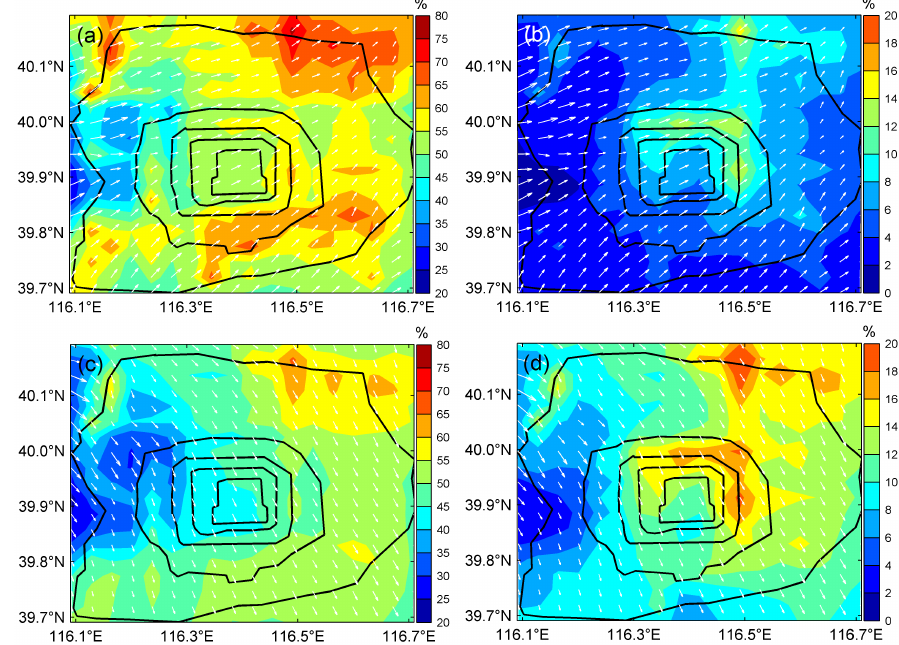
Figure 9. The spatial distribution of mean contribution rate of vehicle emission on NO 2 and PM 2 . 5 in July (a, b) and December (c, d) 2013. Black lines represent the main traffic arteries in Beijing; white arrows represent near-surface mean wind field.